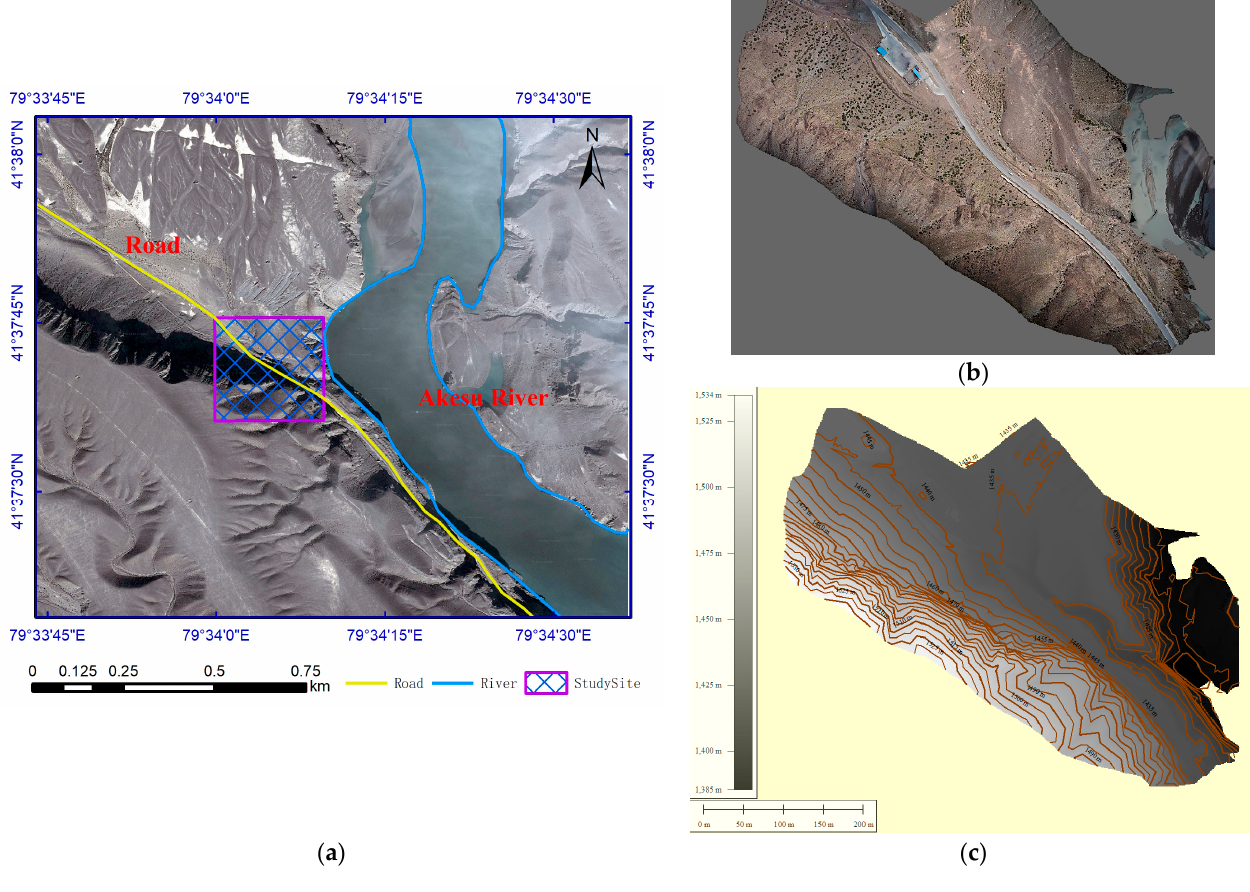
Figure 1. An illustration of the location and topography of the study site. ( a ) The location of the study site. ( b ) The digital ortho model of the study site. ( c ) The digital elevation model and contour of the study